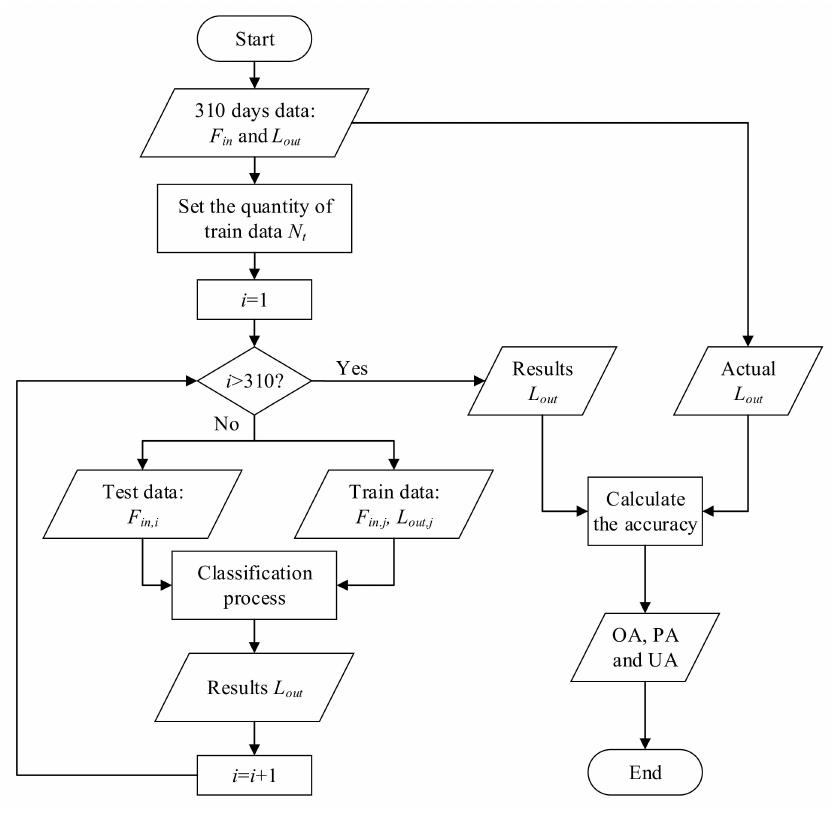
Figure 9. The process of the simulation